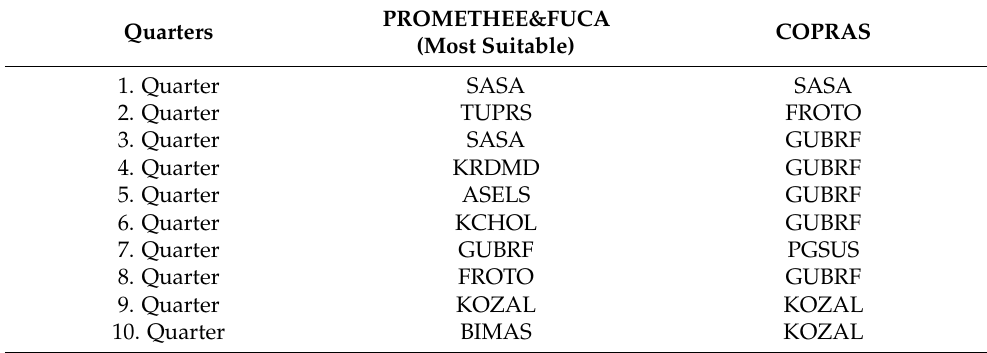
Table 12. Top Performers by PROMETHEE&FUCA and COPRAS in the 10th Quarter